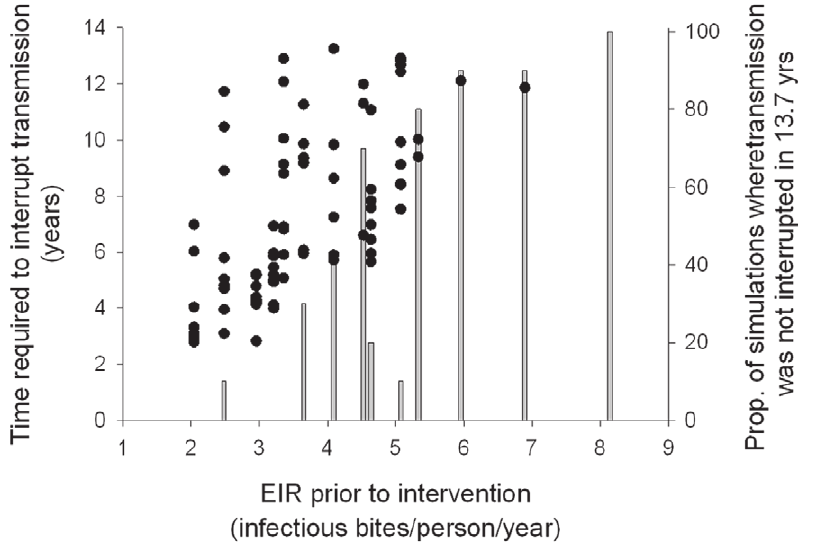
Figure 2. Times required to interrupt malaria transmission and probability under the T90 + bed net intervention. Filled symbols indicate times to interruption. Bars illustrate the proportion of simulations in which transmission was not interrupted within 5,000 days (13.7 years). Ten simulations using identical starting conditions for each initial EIR were conducted.